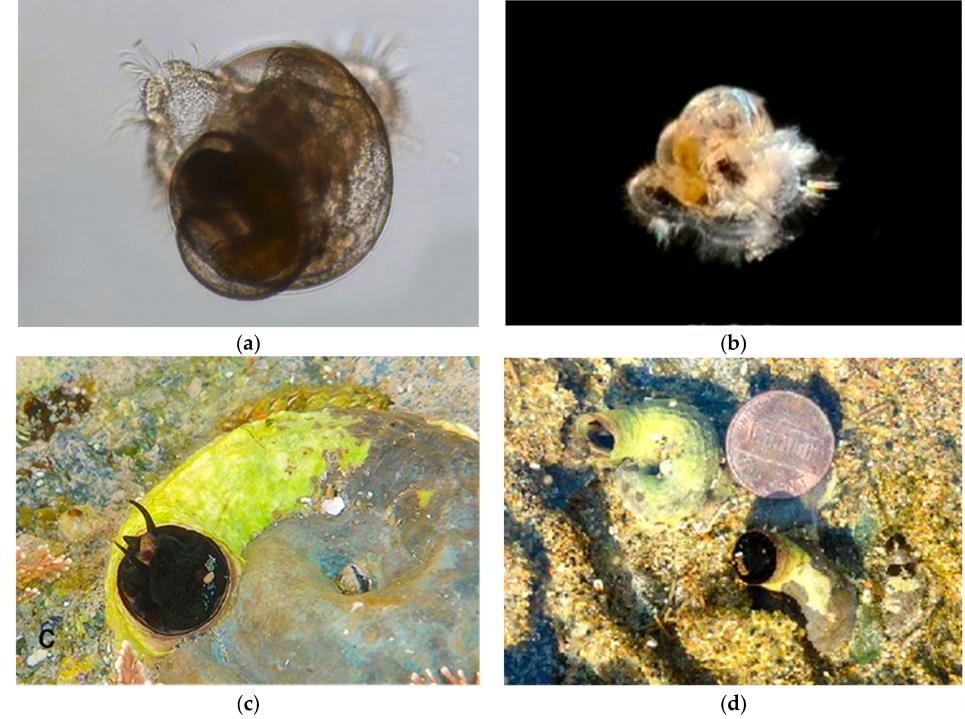
Figure 10. Family Vermitidae. Scaly Worm Shell, Thylacodes squamigerus . ( a ) Veliger, BIOUG01205-B01. Off Crystal Cove State Park, Laguna Beach, Orange County, CA. ( b ) Veliger, BIOUG01229-D05. Off Newport Pier, Orange County, CA. ( c ) Adult CCDB 31729 A11 from Twin Points, Laguna Beach. ( d ) Adult CCDB-24002-C03 from Shaw’s Cove, Laguna